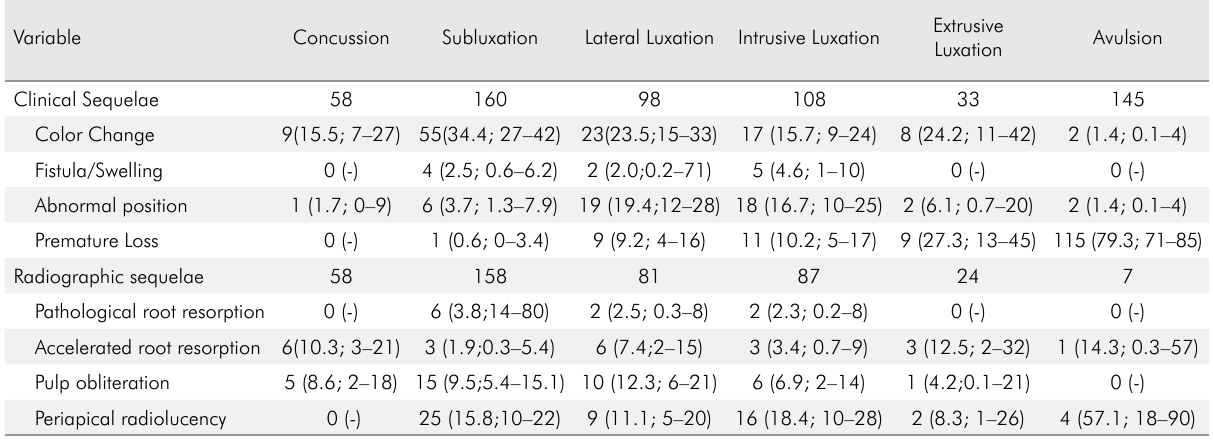
N = number of diagnosed events; % = estimated risk; 95%CI = 95%